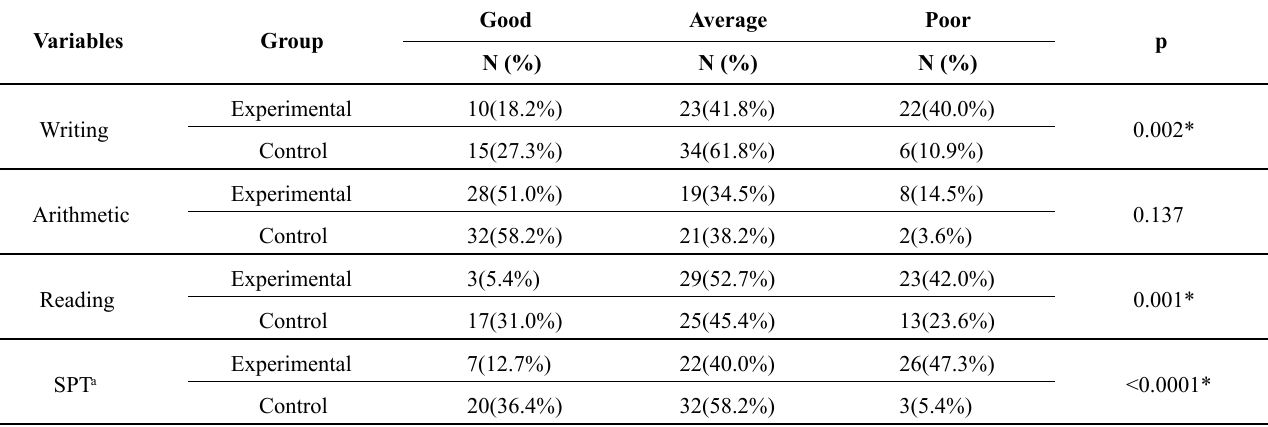
Table 2: Frequency (N) and percentage (%) of students by group who were classified into good, average, or poor school performance categories via the School Performance Test (SPT) Variables